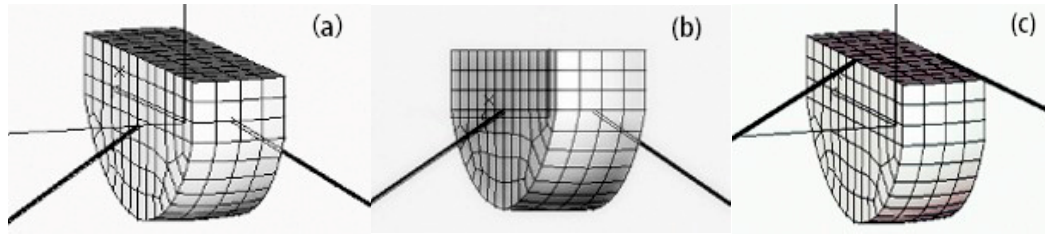
Figure 5. The anchor chain mooring location distribution. (Sub-figures: ( a ) mooring location on centroid; ( b ) mooring location on waterline; ( c ) mooring location on